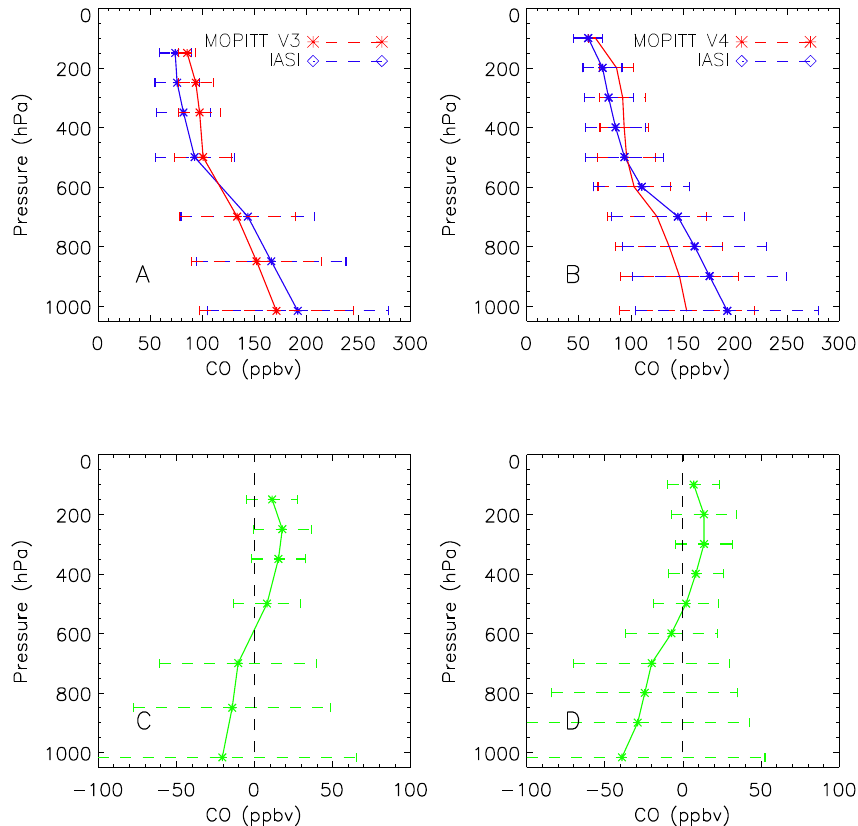
0 and x IASI : (A) adjusted